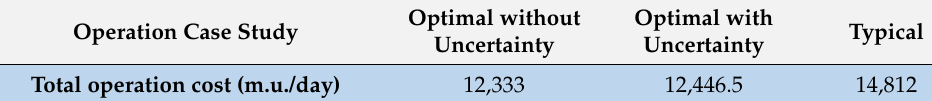
Table 2. Examined operation case studies. Operation Case